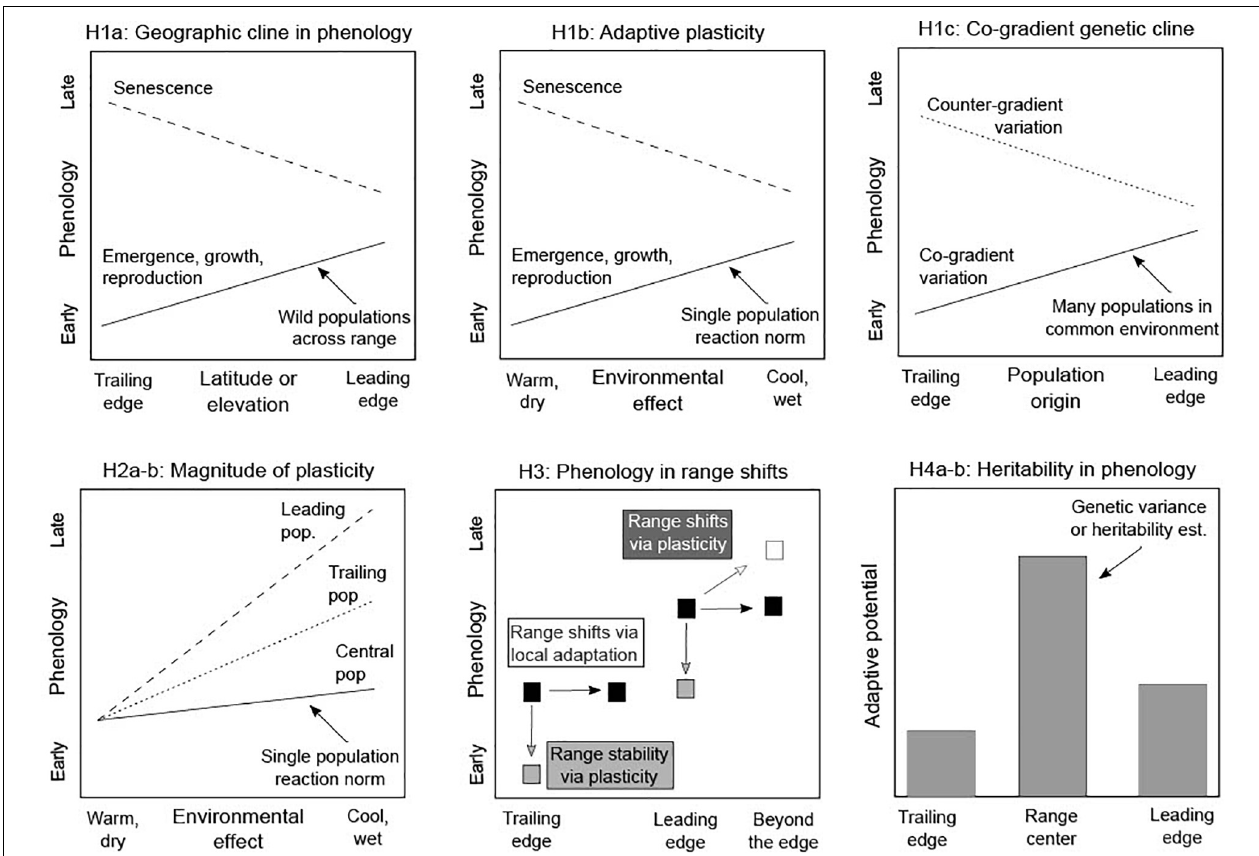
FIGURE 2 | Conceptual diagram illustrating hypotheses for the potential role of phenological plasticity in range shifts under climate change. (H1) Each line indicates the slope of phenological responses across a geographic gradient spanning (a,c) the trailing (equatorial/low elevation) to leading (poleward/high elevation) edge or (b) an associated environmental gradient wherein trailing edge populations experience warmer, drier conditions while leading edge populations experience colder, wetter conditions. (H1a) Phenology demonstrates a geographic cline in wild populations; later onset of spring and colder environments at high latitude and elevation should result in delayed emergence, slower growth and development, and delayed reproduction (solid line), and earlier senescence (dashed line) in leading relative to trailing edge populations. (H1b) Phenology demonstrates adaptive plasticity, such that individual populations grown in common conditions respond to environmental variation (i.e., reaction norm) by altering phenology in a way that is consistent with geographic clines in H1a (note that warmer populations are on the left side of the axis, consistent with the trailing edge). (H1c) Phenology demonstrates co-gradient genetic variation (solid line), such that populations grown in common environments demonstrate genetic differences mirroring geographic clines (vs. counter-gradient genetic variation; dotted line). (Expectations for spring phenology shown.) (H2) Each line represents the reaction norm for a single population (solid = central; trailing = dotted; dashed = leading) grown under contrasting environmental conditions (warm/dry vs. cool/wet) (e.g., in common gardens or climate manipulations). (H2a) The magnitude of phenological plasticity (i.e., responsiveness to environmental variation) is greater in populations from range edges vs. centers, and (H2b) from leading edges vs. trailing edges. (H3) Boxes show the range shift of a population in space. Phenological plasticity may allow populations to suitably shift their phenology to persist in situ (i.e., “range stability,” light gray boxes) or to expand beyond the range edge (white box). Alternatively, local adaptation in phenology can drive range shifts by causing populations to track suitable climate for a given phenology in space (black boxes). (H4a) Adaptive potential in phenology (i.e., genetic variance or heritability) is greater in populations from range centers vs. edges, and (H4b) from leading vs. trailing